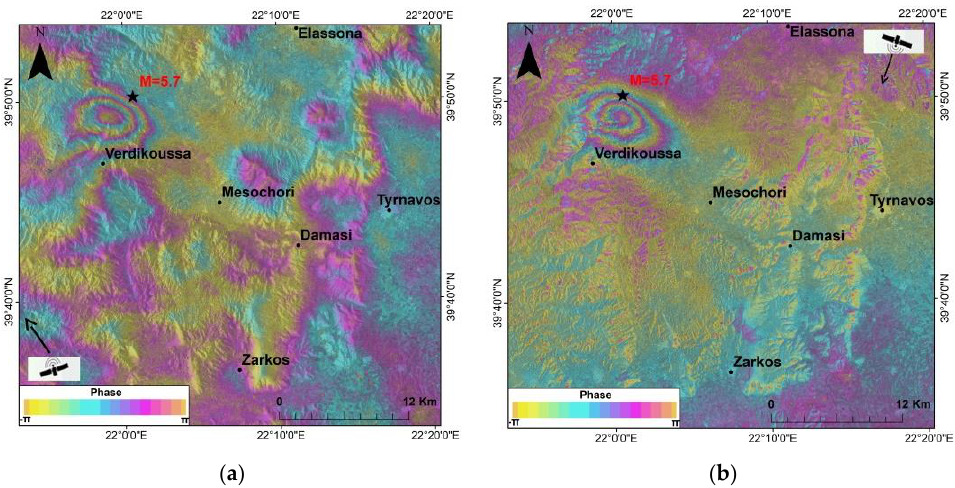
Figure 17. Earthquake of 12 March 2021: Wrapped interferograms in ( a ) ascending (9 March 2021 master and 15 March 2021 slave image) and ( b ) descending (8 March 2021 master and 14 March 2021 slave image) mode; star illustrates the relocated epicenter.